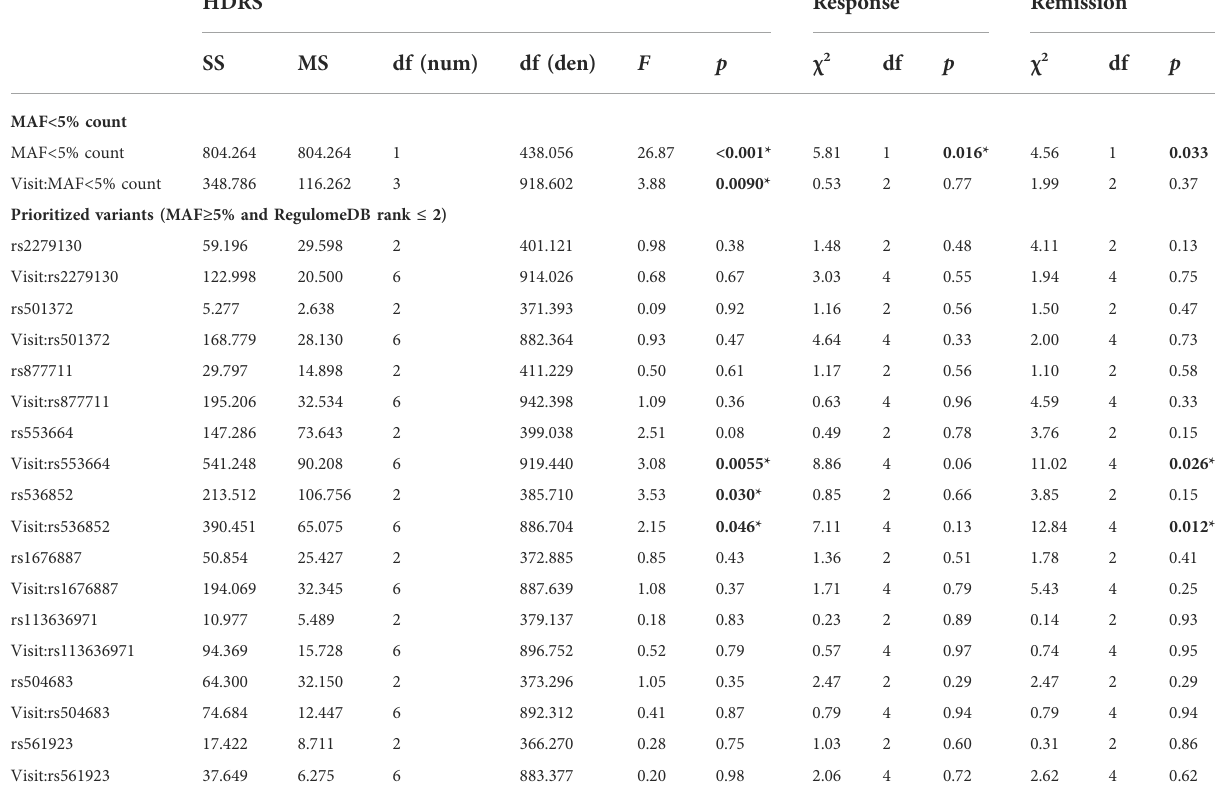
TABLE 4 Mixed-effects model results. Associations for each of the clinical measures (HDRS, response, and remission) with 1) the rare (i.e., MAF < 5%) variantcountanditsinteractionwithvisit(i.e.,time)and2)the9prioritized frequent (i.e.,MAF ≥ 5%andRegulomeDBrankof1or2)SNPsanalyzed and their interactions with visit. Signi fi cant (i.e., p < 0.05) associations are highlighted in dark gray and bolded. Signi fi cance of fi xed effects was assessed with the Satterthwaite method in mixed-effects models of the HDRS score and with the Wald chi-square test in mixed-effects models of response and remission. All models were adjusted for age, sex, antidepressant class, and any sociodemographic characteristics that signi fi cantly (bold text and *: p < 0.05) differed between genotypes (see Supplementary Table